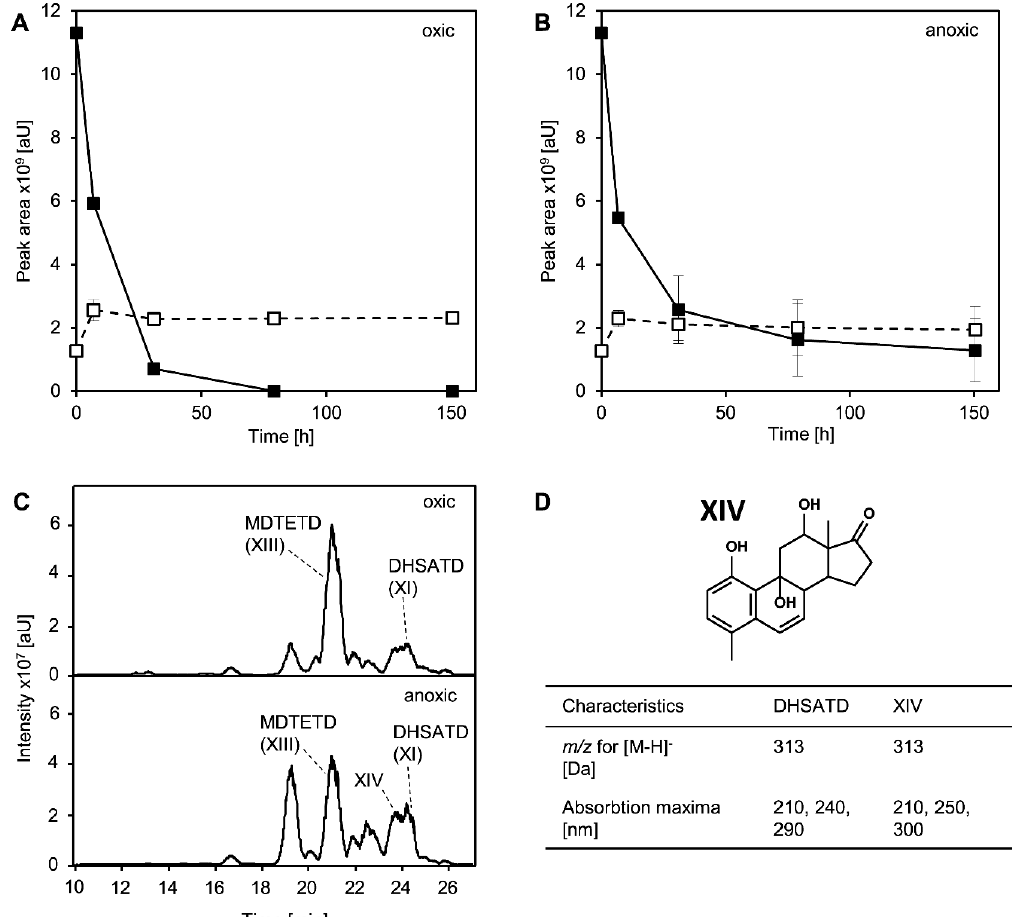
Figure 6. Degradation of DHSATD (XI in Figure 1, closed squares) and formation of MDTETD (XIII, open squares) by suspensions of cholate-grown cells of Sphingobium sp. strain Chol11 (initial OD 600 = 0.13) under oxic ( A ) and anoxic ( B ) conditions. ( C ) HPLC-MS analyses of supernatants after 31 h of oxic (top) and anoxic (bottom) incubation. MS base peak chromatograms measured in negative mode are shown. ( D ) Proposed structure for a steroid compound named XIV found in cell suspensions incubated anoxically with DHSATD and comparison of characteristics of DHSATD and XIV. The struc- ture suggestion is based on m / z values and absorption spectra. Error bars indicate standard deviation, which may not be visible if too small ( n = 3).